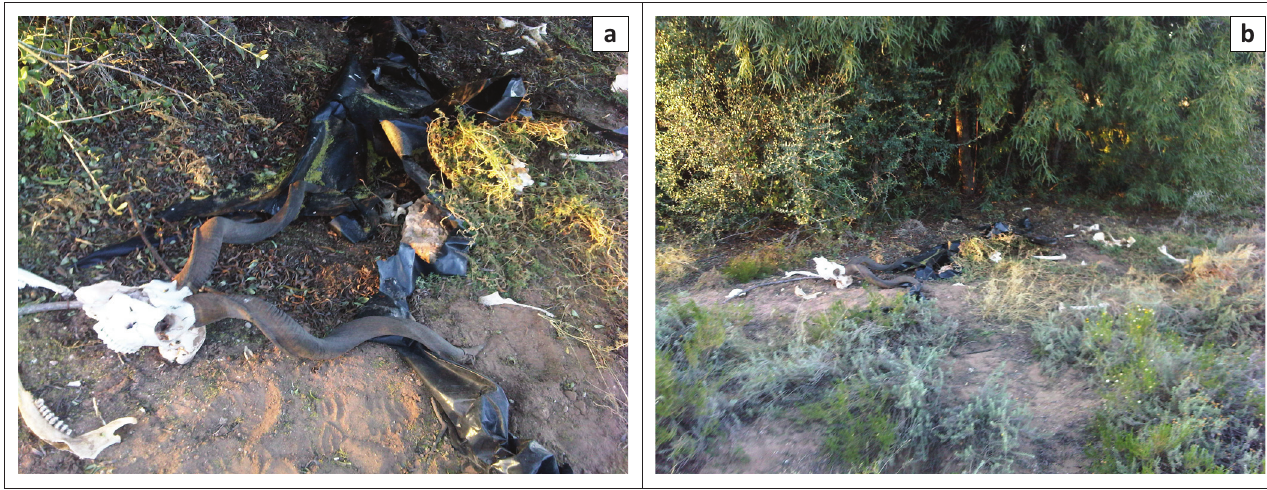
FIGURE 4: Soil and bone samples collected ( n = 62) in 2012 from farms and carcass sites identified as anthrax-positive by farmers and State Veterinary Services in 2007–2008, South Africa. Additional soil samples were taken along water runoff paths following the Ghaap escarpment drainage topography (indicated as the diagonal ridge line across the map).